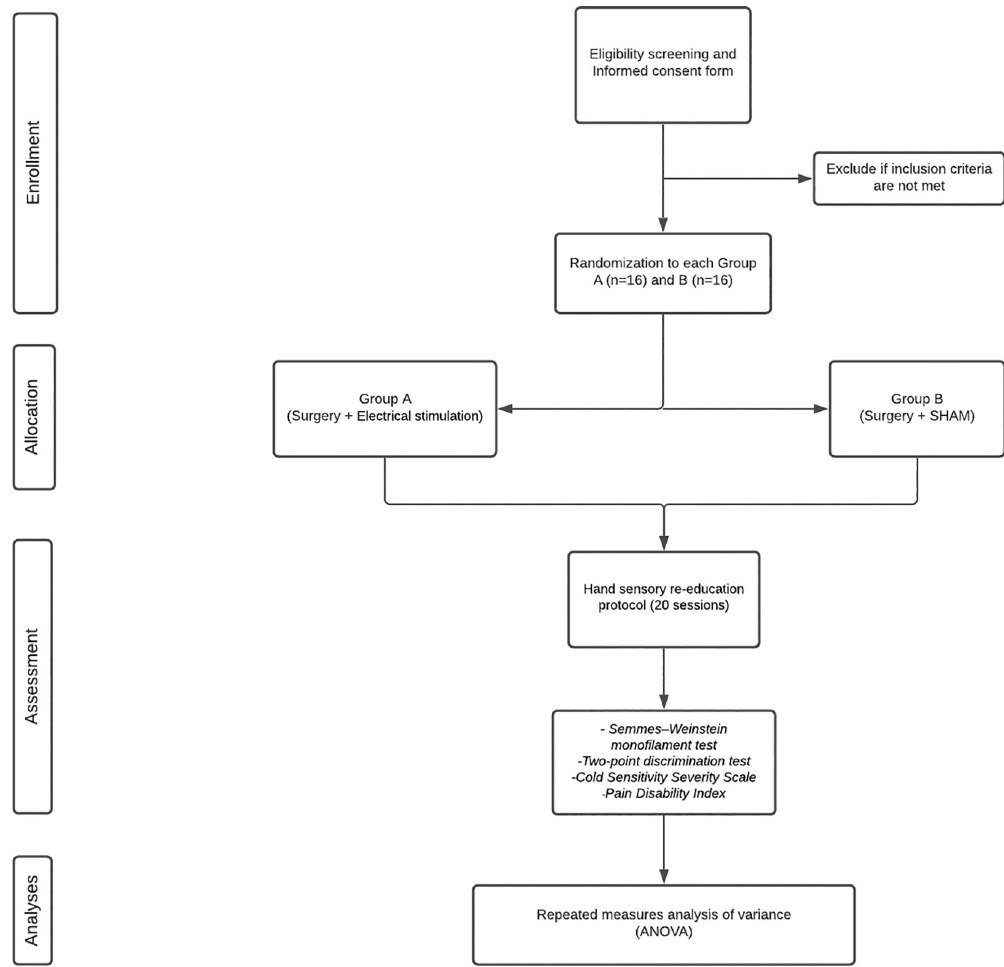
Figure 1. Flow chart of the study based on CONSORT